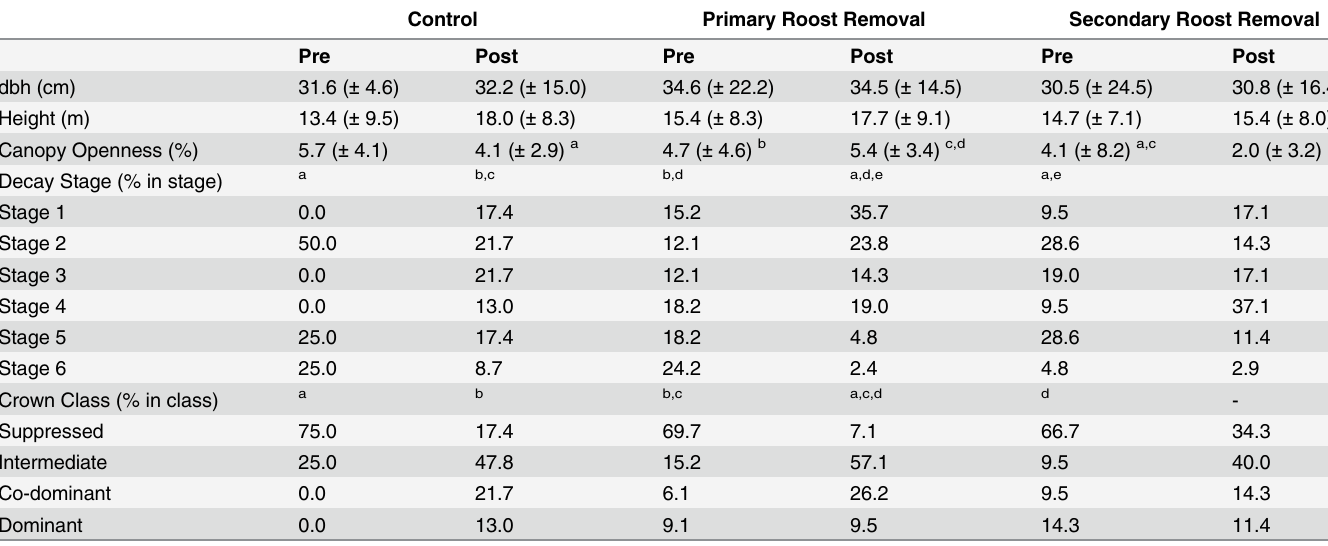
Table 3. Summary of female northern long-eared bat roost characteristics.